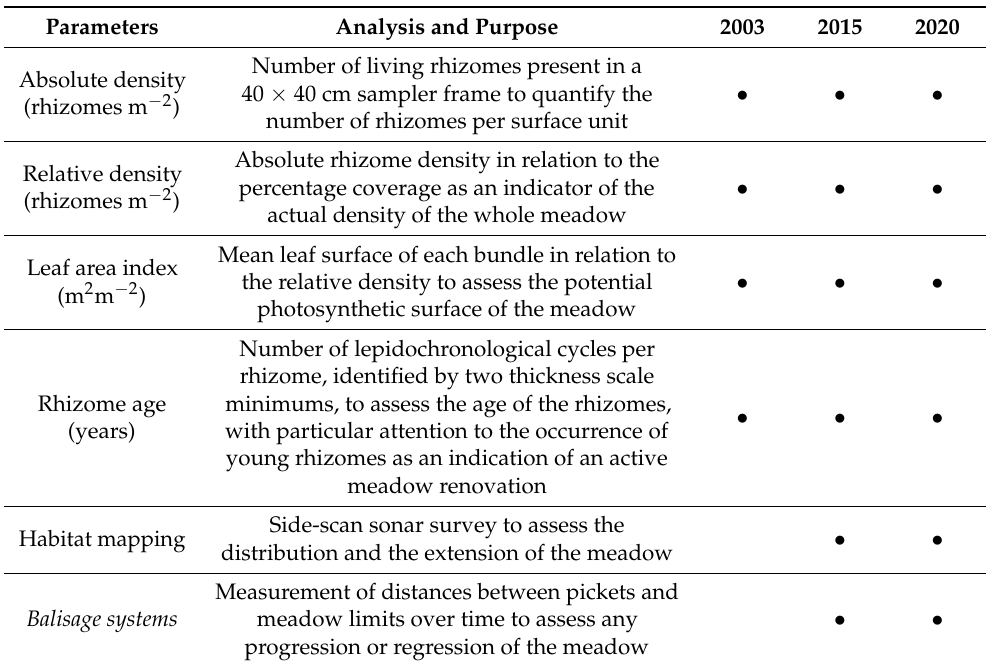
Table 2. Synopsis of the parameters considered during each monitoring and analysis performed to assess each parameter. Dots were used to indicate that the parameters were calculated during